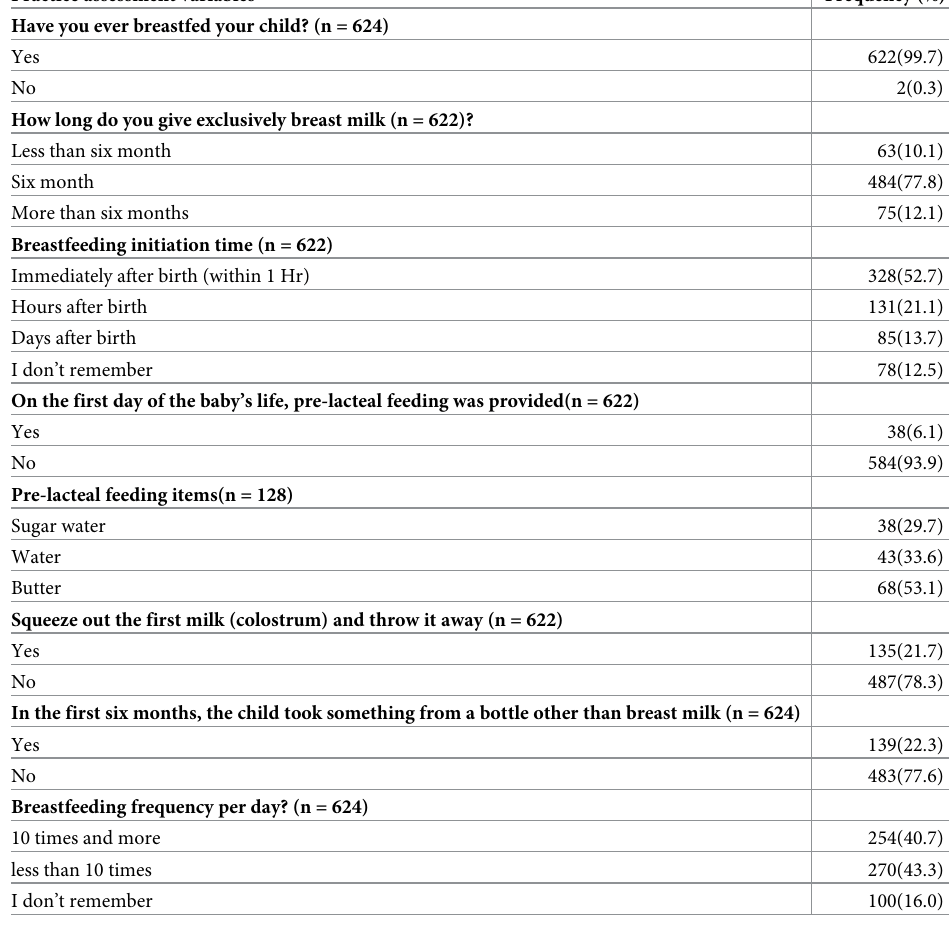
Table 3. Exclusive breastfeeding practice among mothers of children aged 6–24 months of age in Lemo District, Southern Ethiopia, 2021. Practice assessment